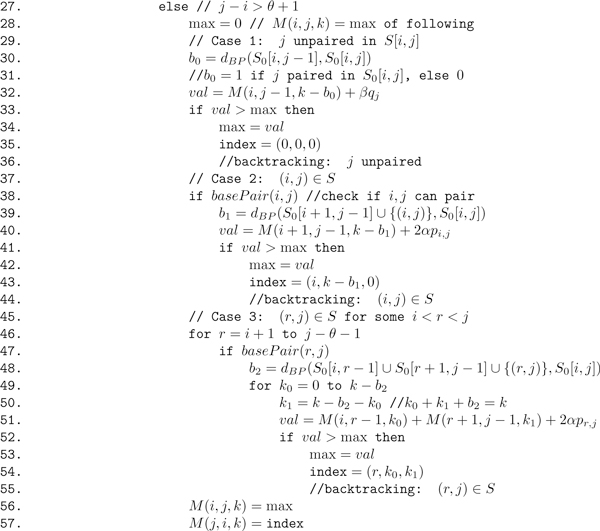
Pseudocode for RNAborMEAalgorithm. Given RNA sequence s = s1, .. ., sn of length n, initial secondary structure S0 of s, RNAborMEA computes for all values of 0 ≤ k ≤ n that structure S with base pair distance k from S0, which maximizes the value M(i,j,k)= ∑(i,j)∈S2αpi,j+∑iunpaired in sβqi. The pseudocode actually computes only values M(i, j, k) for all i, j, k; the MEA structures are obtained by backtracing. This algorithm clearly runs in O(n3) time with O(n3) space.